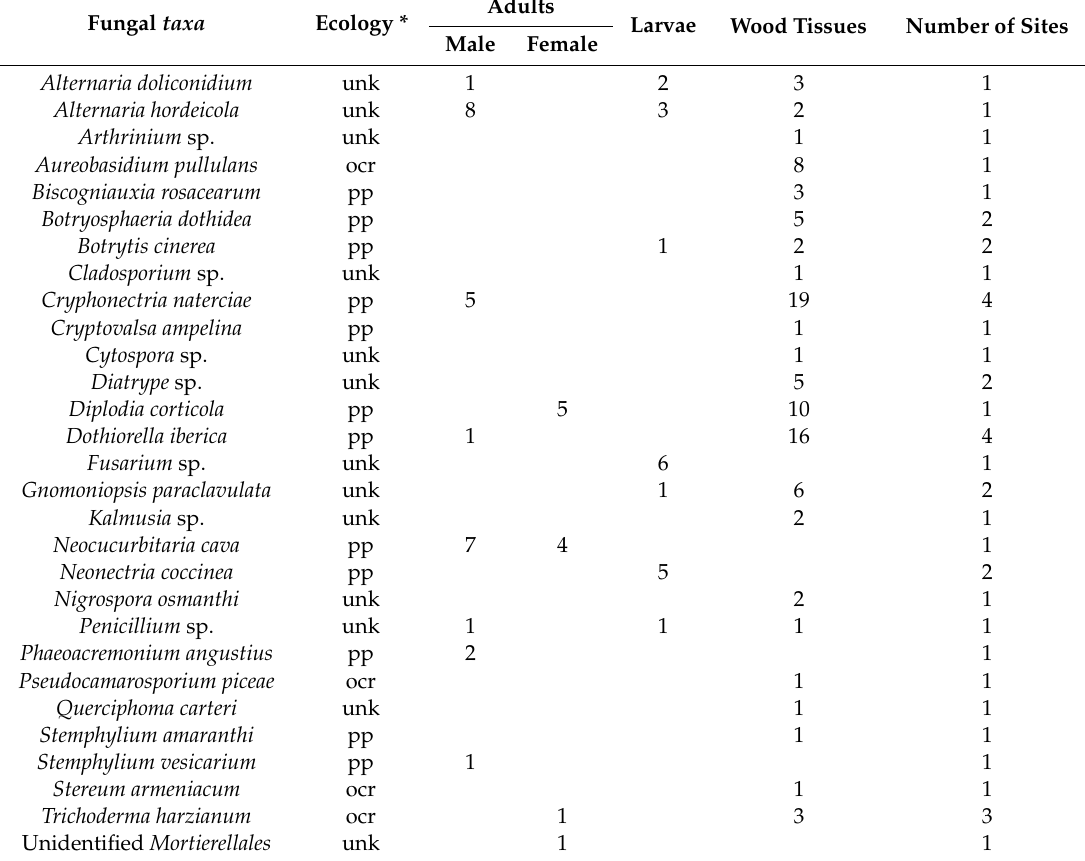
Table 4. Number of fungal isolates obtained from insects and wood tissues of bored oak